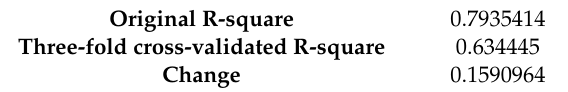
Table 6. Cross-validation output